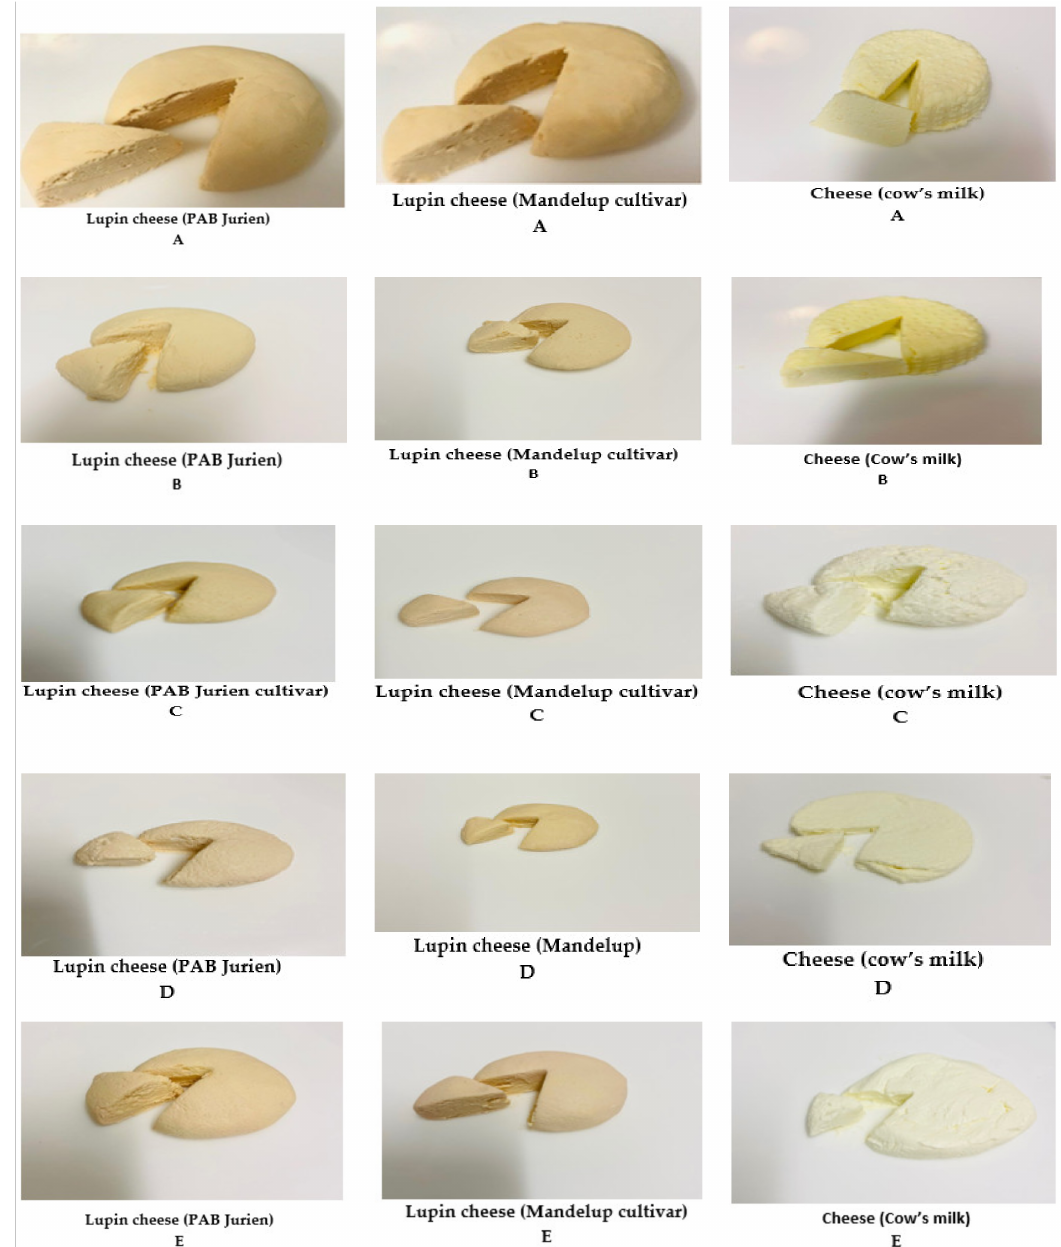
Figure 4. Physical appearance of cheese produced from lupin milk of two cultivars and cow’s milk using different coagulation methods whereas, A = vinegar, B = lemon juice, C = starter culture, D = rennet enzyme, and E = rennet enzyme + starter culture